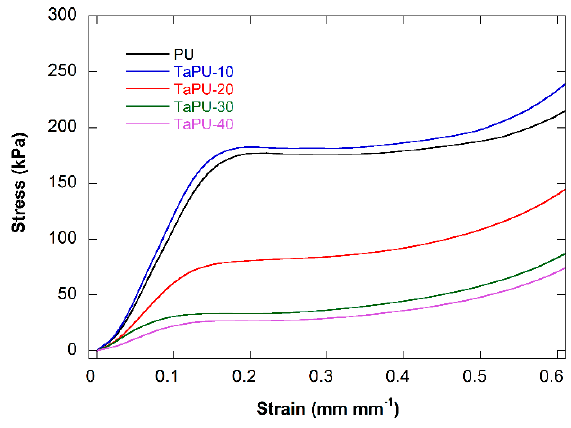
Figure 5. Stress/strain curves of PU and TaPU foams.